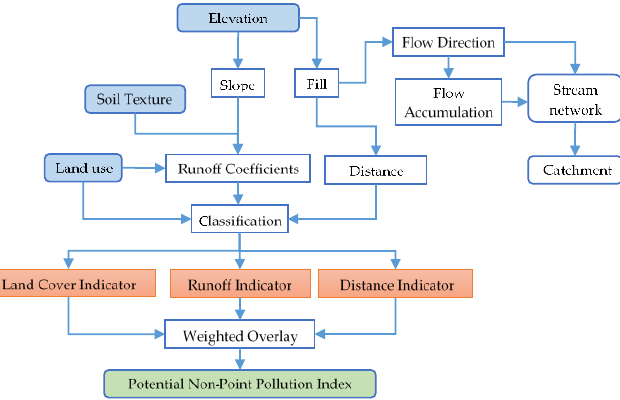
Figure 3. Workflow in calculation of potential non-point pollution index (PNPI).